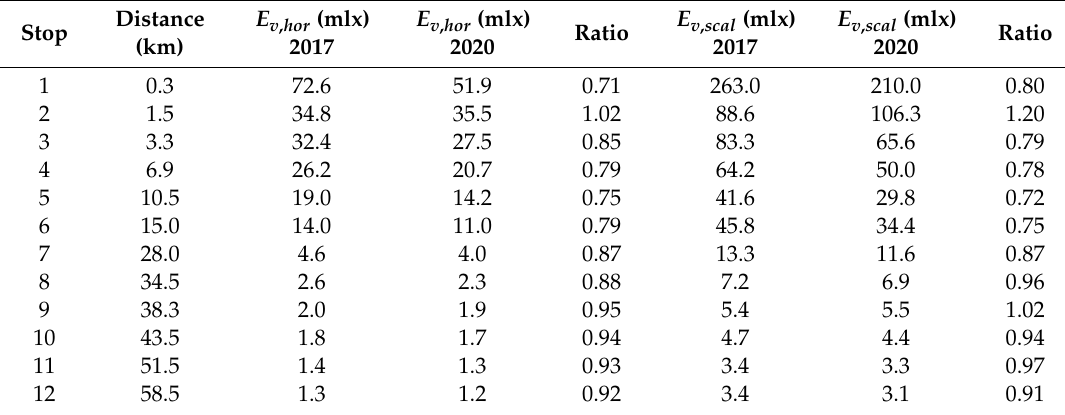
Figure 5. ( a ) Horizontal and ( b ) scalar illuminance for different distances from the city center of Berlin, Germany, measured during a clear night in 2017 (black solid line and circles) and a clear night during the COVID-19 lockdown in 2020 (grey dashed dotted line and boxes). Table 3. Horizontal illuminance ( E v , hor ) and (hemispheric) illuminance ( E v , scal , hem ) data for the two measurement transects and ratios for 2017/2020.